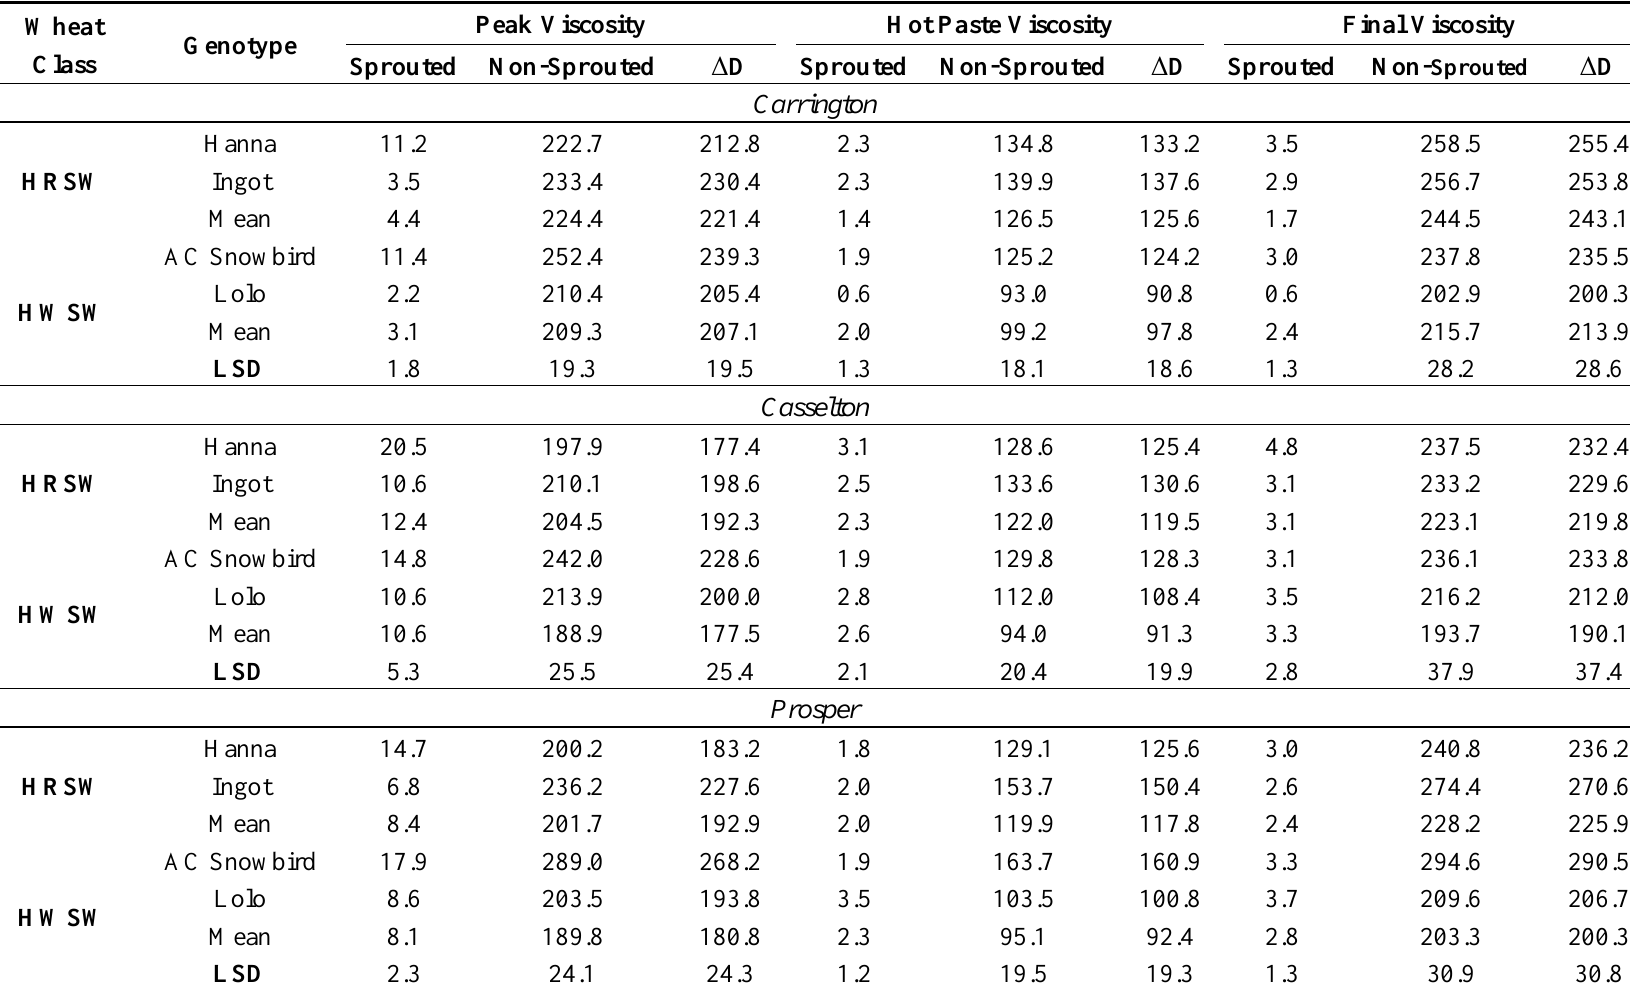
Table 2. Mean value of pasting profile of check varieties; Hanna, Ingot, Lolo and AC Snowbird; and means of wheat classes from Carrington, Casselton and Prosper for sprouted wheat, non-sprouted wheat and their difference